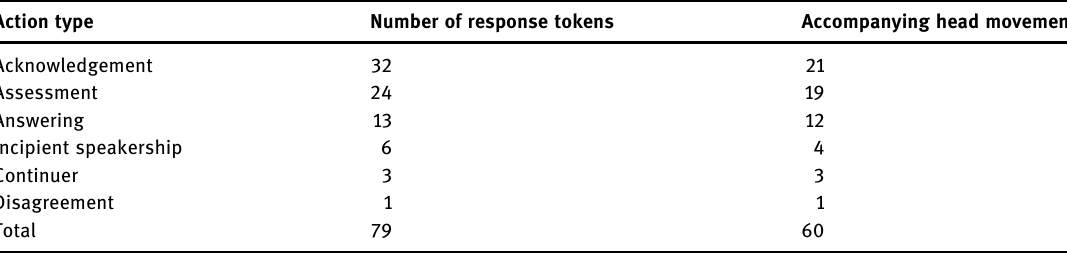
Table 1: Action - type classi fi cation for “ mm ” as a response token Action